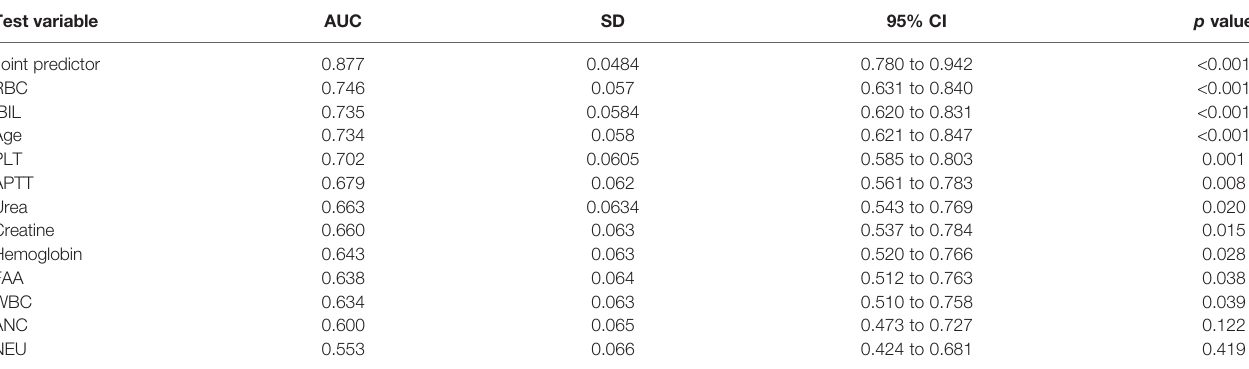
TABLE 6 | AUC of each test variable.